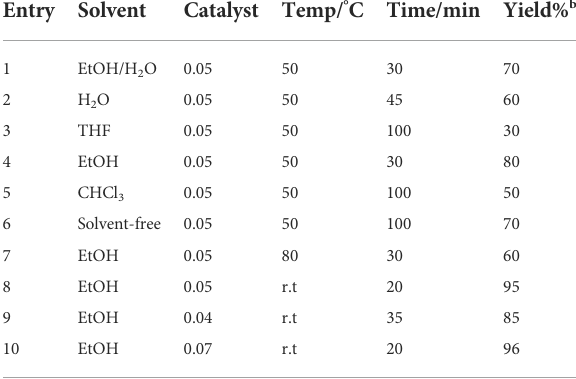
TABLE 3 Optimization of the reaction of 3-methyl-1-phenyl- 1 H -pyrazol-5-ol, and benzaldehyde, under various conditions a . Entry Solvent Catalyst Temp/ ° C Time/min Yield% b